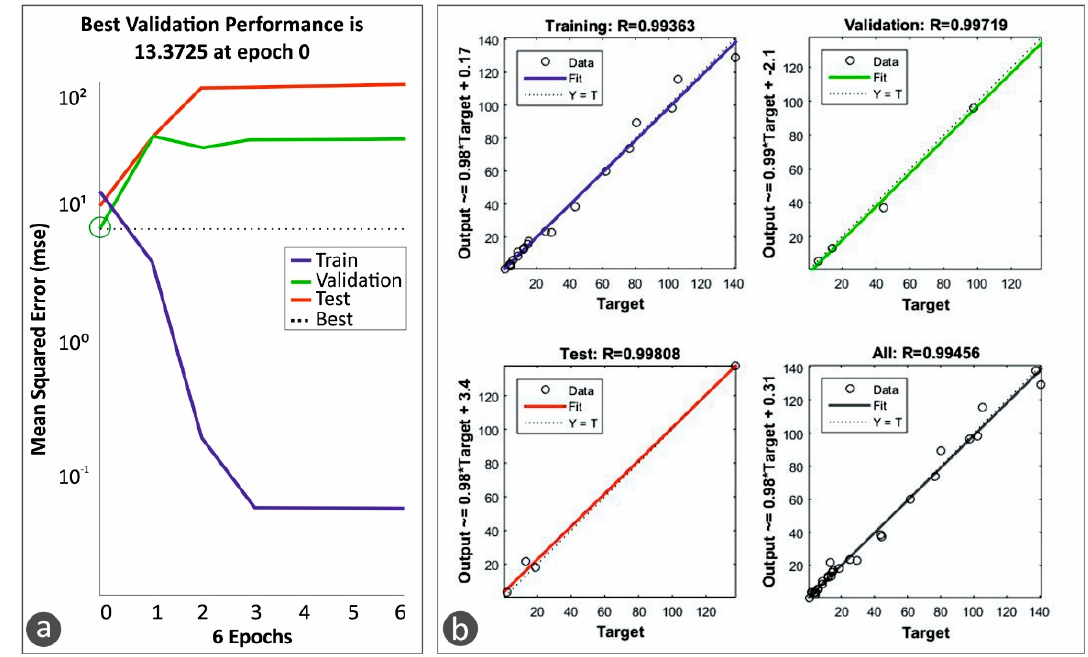
Figure 8. ( a ) PURELIN linear transfer function; ( b ) TANSIG hyperbolic tangent sigmoid transfer function.